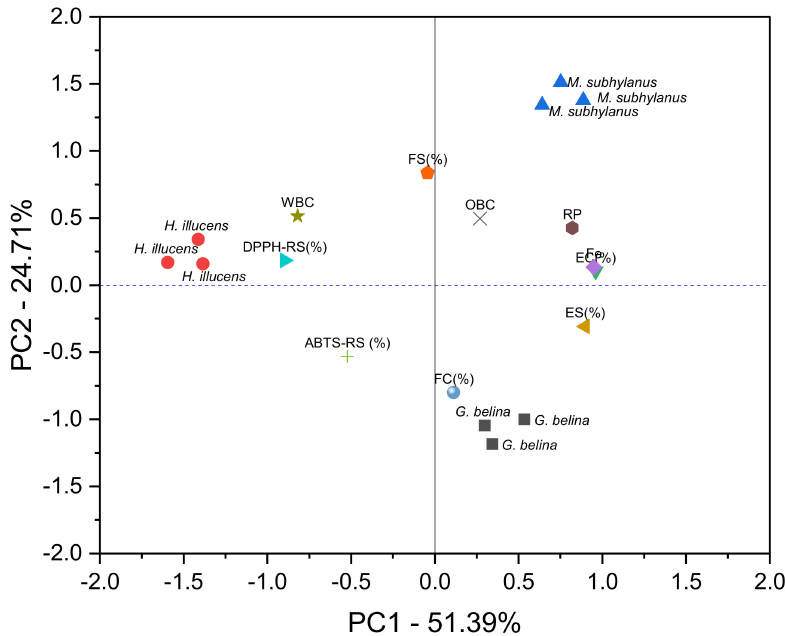
Figure 5. Principal components analysis plot for techno-functional properties and antioxidant indices of edible insect